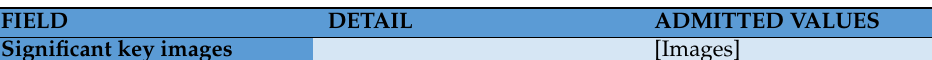
Table A7. IMAGES.